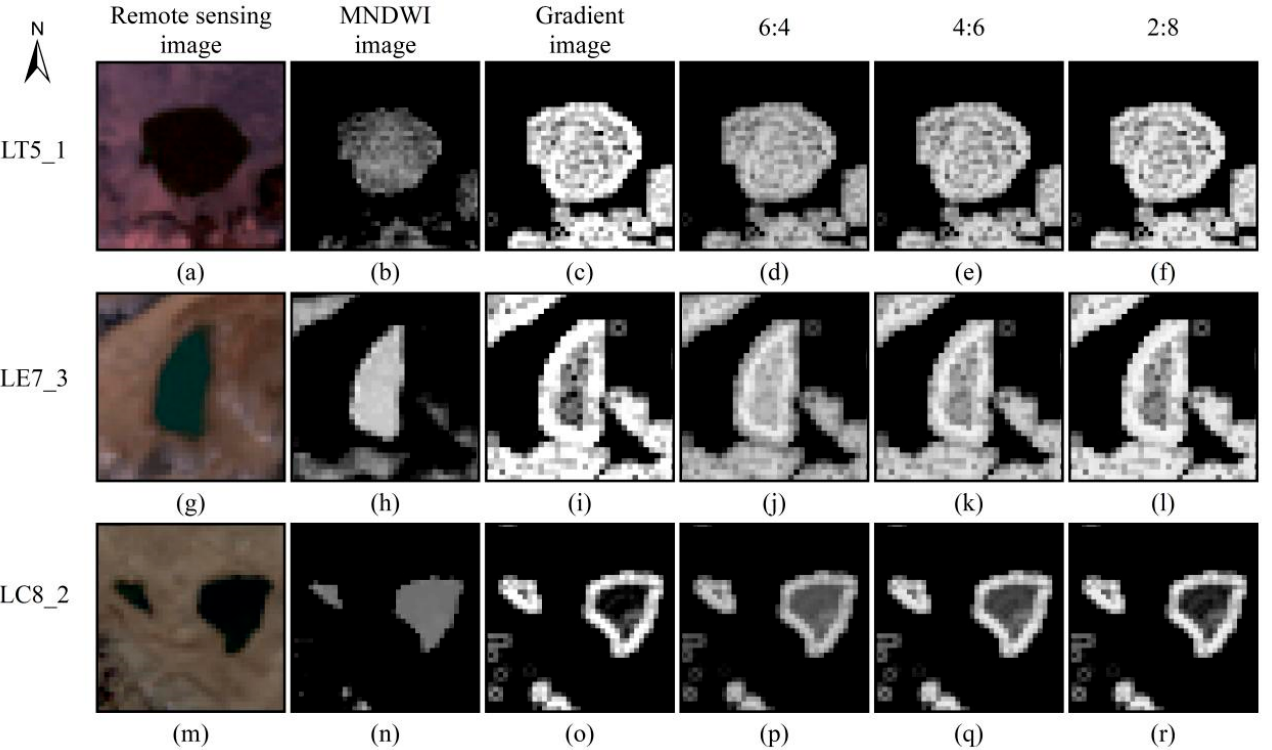
Figure 7. Merged image with different merging weights: ( a , g , m ) are from the original remote sensing images of the three experimental areas, respectively; ( b , h , n ) are MNDWI images corresponding to ( a , g , m ), respectively; ( c , i , o ) are gradient images corresponding to ( a , g , m ), respectively; ( d , j , p ) are merged images with the weight setting of 6:4 corresponding to ( a , g , m ), respectively; ( e , k , q ) are merged images with the weight setting of 4:6 corresponding to ( a , g , m ), respectively; ( f , l , r ) are merged images with the weight setting of 2:8 corresponding to ( a , g , m ), respectively.